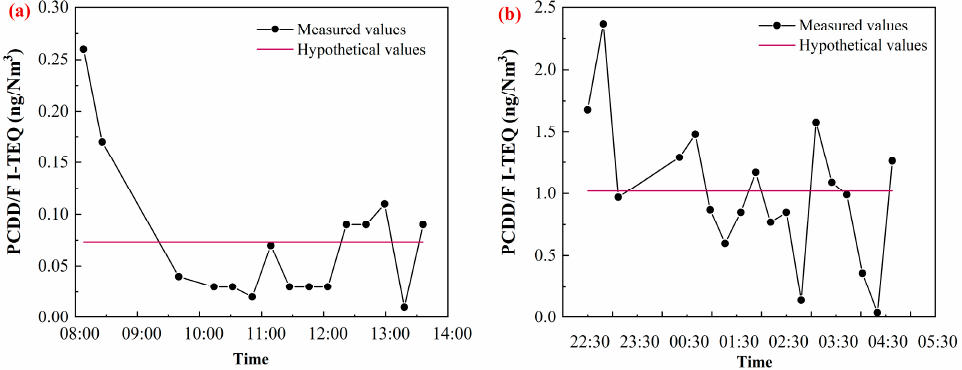
Figure 4. Comparison of hypothetical values of offline measurement and online measurement; hypothetical values represent the average values in continuous 6 h by TD-GC-REMPI-TOFMS. ( a ) low emissions under stable operation ( b ) high emissions under fluctuant operation.